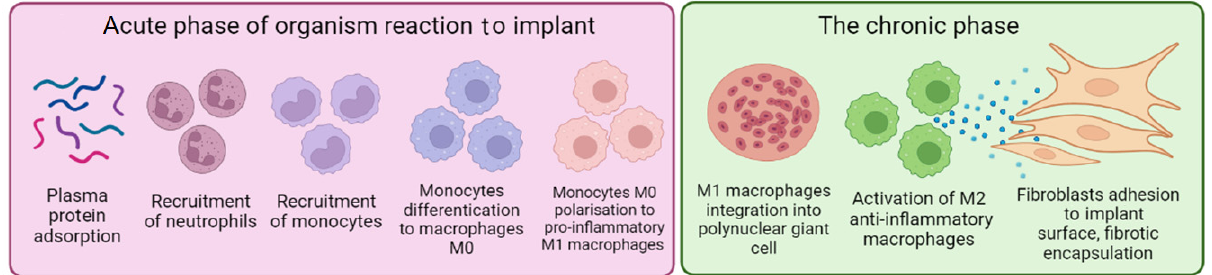
Figure 1. Two basic stages of body response after implantation of foreign material (the figure was made using app.biorender.com, accessed on 18 August